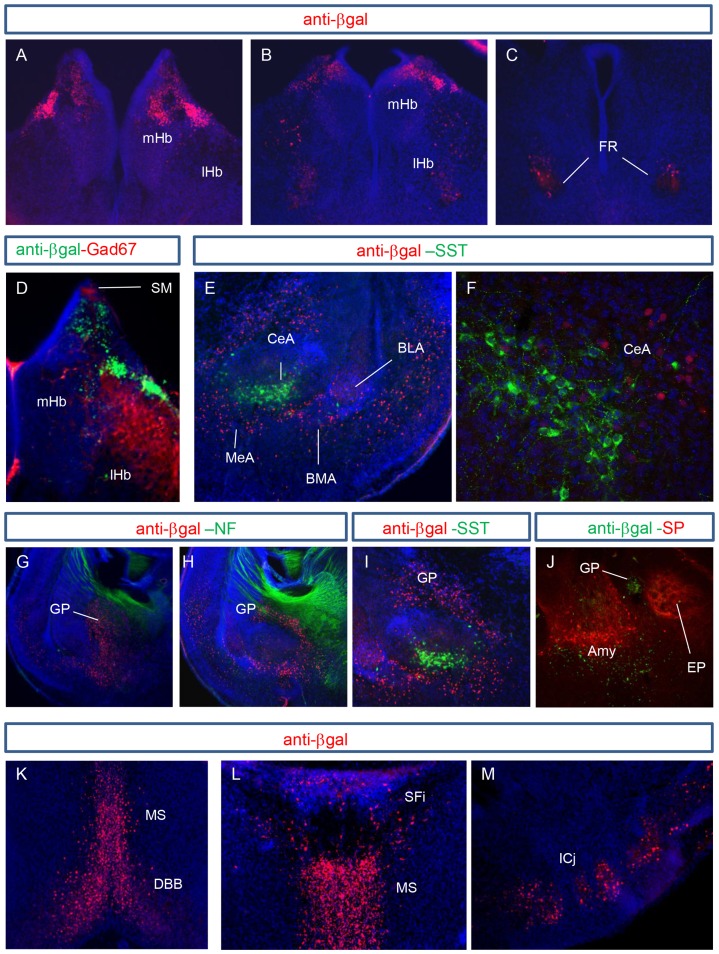
Elfn1 expression in subcortical structures of the mouse brain.(A–C) The β-gal reporter is expressed throughout the rostrocaudal extent of the habenula. In a rostral coronal section (A) staining is limited to the dorsolateral MHb and absent from the LHb. Further caudally staining is restricted to a smaller subset of cells in the dorsolateral MHb, and in scattered cells of the central LHb (B). In a caudal-most section, β-gal staining is absent from the MHb, and a few positive cells are located in the ventral LHb at the fasciculus retroflexus (C). (D) GAD67 staining is localised to the stria medullaris, and the lateral habenula. There is no overlap in β-gal and GAD67 staining in the MHb. (E) β-gal expression is evident in the medial (MeA), basomedial (BMA) and basolateral amygdala (BLA). Scattered cells in the central (CeA) are also positive for β-gal. Double immunoreactivity with β-gal and SST antibodies identify that expression of these two proteins are largely in separate regions of the amygdala. (F) A magnified confocal image of (E) shows that βgal-positive cells do not contain SST. (G,H) β-gal is expressed throughout the rostrocaudal extent of the globus pallidus. In a rostral section of the GP there is a strong lateral to medial gradient (G) and staining is also evident thoughout the more elongated structure in caudal sections (H). (I) Cells positive for β-gal do not colocalise with cells expressing SST in the globus pallidus. (J) β-gal staining is not observed in the entopeduncular nucleus which is highly immunopositive for Substance P (SP). (K–M) β-gal is also expressed in the medial septum (MS), diaganol band of Broca (DBB), septofimbrial nucleus (SFi) and in the islands of Calleja (ICj). Amy, amygdala; EP, entopeduncular nuleus; FR, fasciculus retroflexus; GP, globus pallidus; lHb, lateral habenula; mHb, medial habenula.